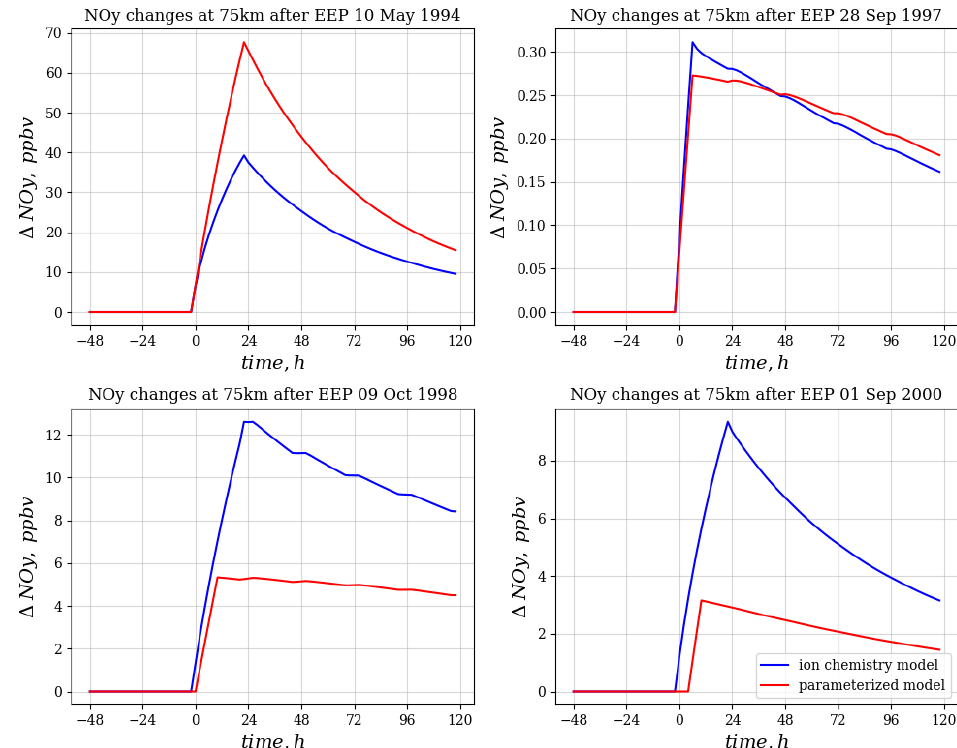
Figure 3. Simulation results of NO y change at 75 km. The 0 on the horizontal scale is midnight of the corresponding day.